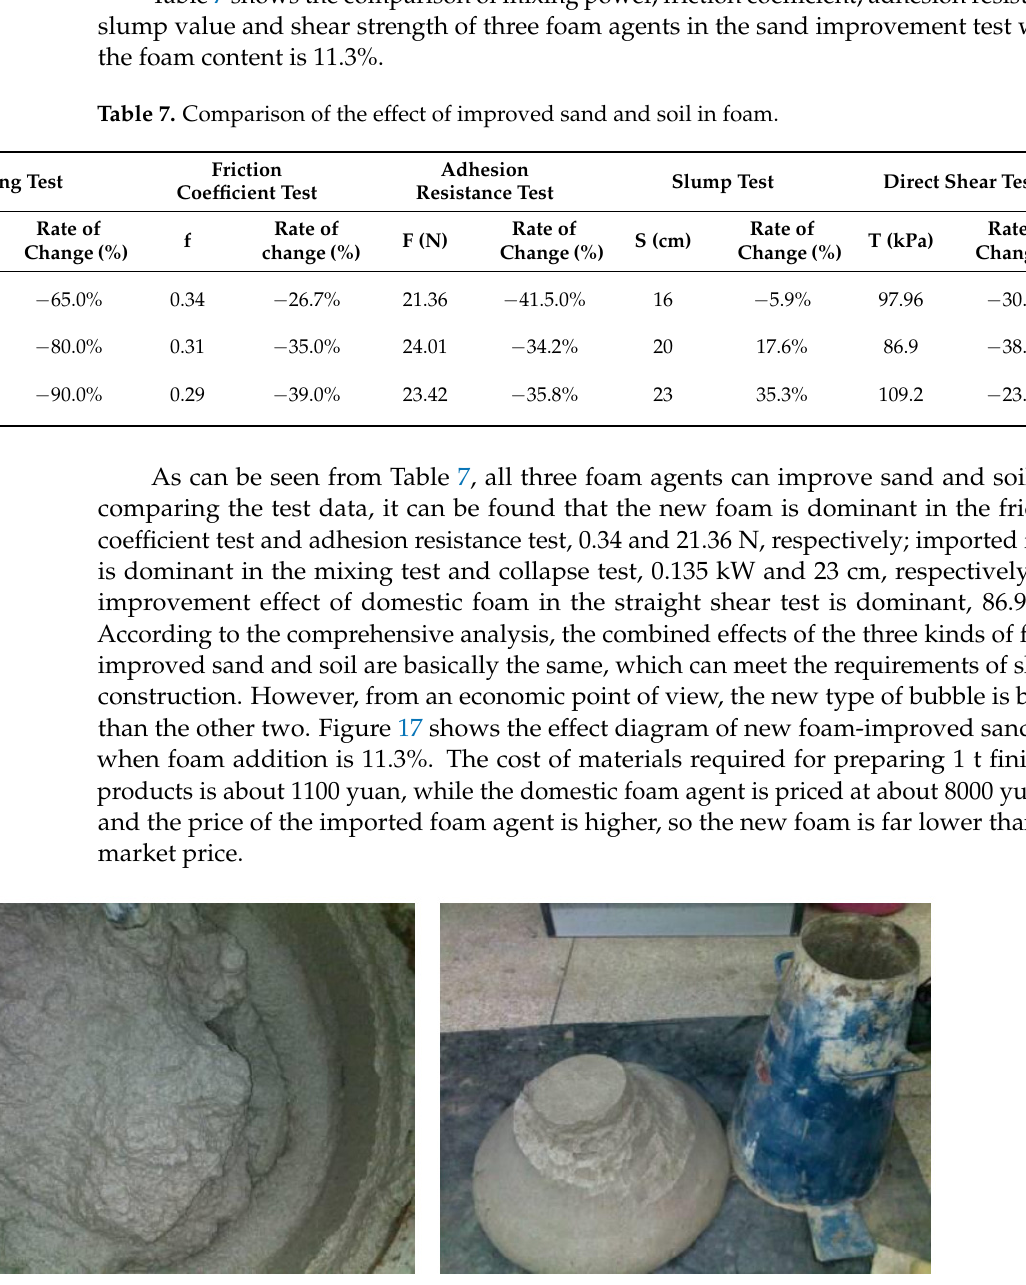
Figure 17. New foam improved sand and soil renderings.